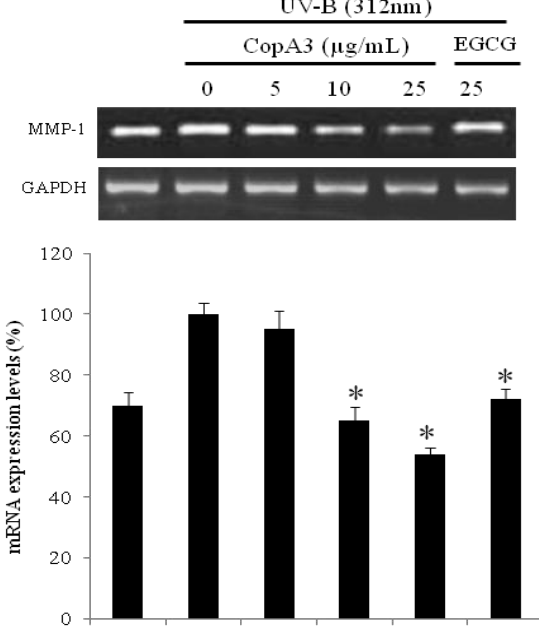
treatment on fibroblast CCD-986sk. After CCD-986sk cells (5 × 10 5 cells) were grown and exposed to UVB for 1 min, the cells were treated with 5, 10 and 25 µg/mL of CopA3 . The mRNA transcripts were detected by RT-PCR. GAPDH was used as internal control.